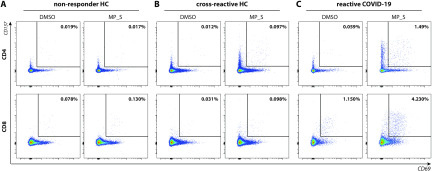
Expression of activation markers in representative samples.(A, B, C) Representative activation plots showing CD69 and CD137 up-regulation from a non-responder HC (A), cross-reactive HC (B) and reactive COVID-19 sample (C). Each panel shows activation after stimulation with DMSO (negative control) or MP_S. Top row shows CD4+ T cell responses, bottom row shows CD8+ T cell responses. Percentages indicate activated CD69+CD137+ cells as a fraction of either CD4+ or CD8+ T cells.